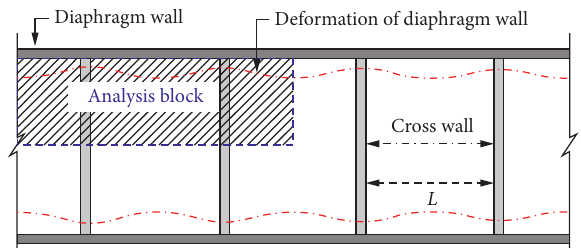
Figure 3: Deformation of the diaphragm-cross wall system.